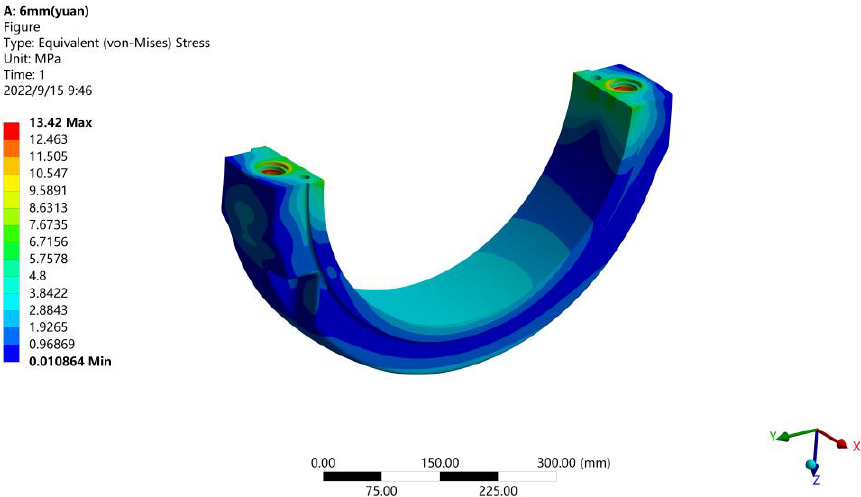
Figure 11. Stress diagram of large end bearing cover of connecting rod.